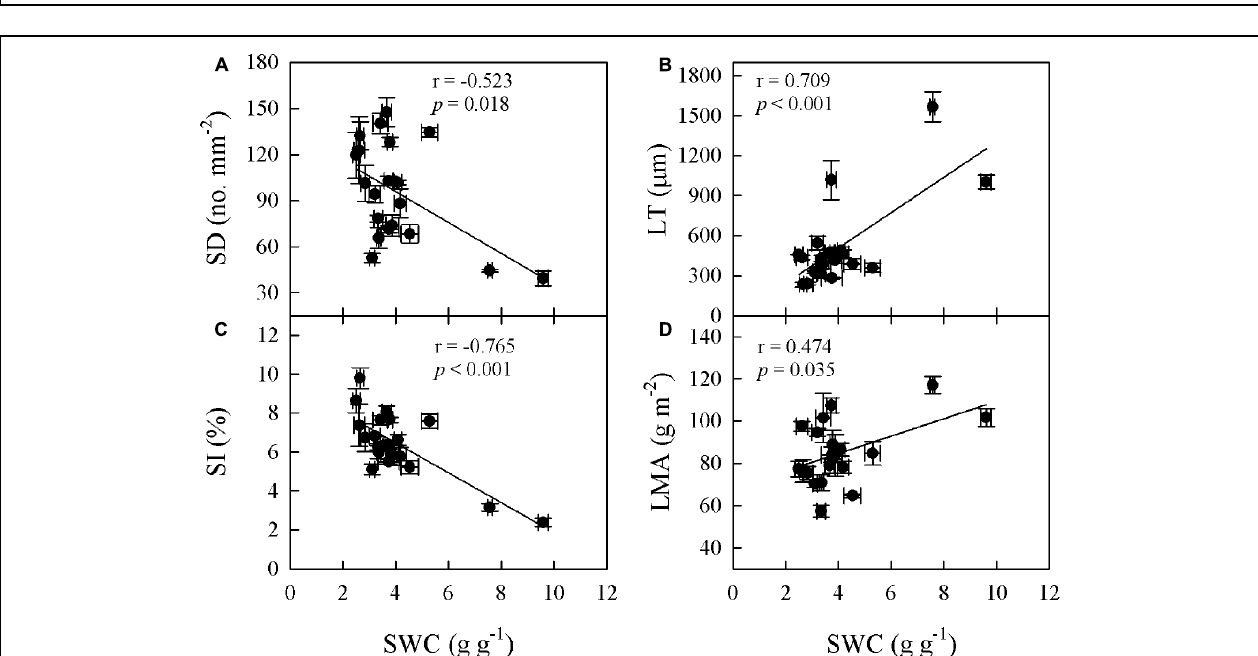
FIGURE 4 | Correlations between SWC and stomatal density (SD; A), SI (C), leaf mass per unit area (LMA; D), and LT (B) across 20 Cymbidium species.